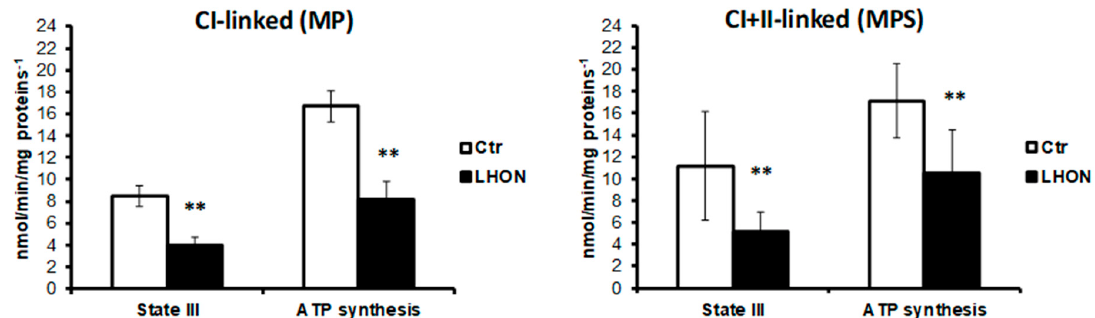
Figure 3. Maximal phosphorylating respiration rate (state III) and the corresponding mitochondrial ATP synthesis rate were determined in LHON ( n = 7) and control ( n = 7) fibroblasts. State III was started either by addition of 5 mM malate and 2.5 mM pyruvate (Complex I-linked respiration) or of 5 mM malate, 2.5 mM pyruvate, and 10 mM succinate (complexes I+II-linked respiration), and phosphorylating respiration was induced by the subsequent addition of 1.5 mM ADP. Statistical significance: ** p < 0.01.